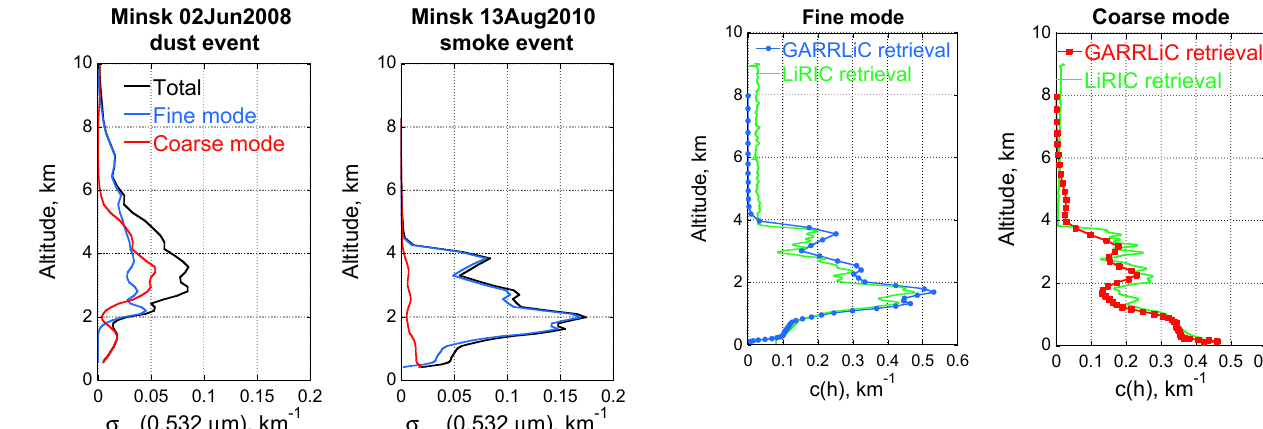
Fig. 22. Comparison of the retrieved vertical profiles with LiRIC inversion for observations on 13 August